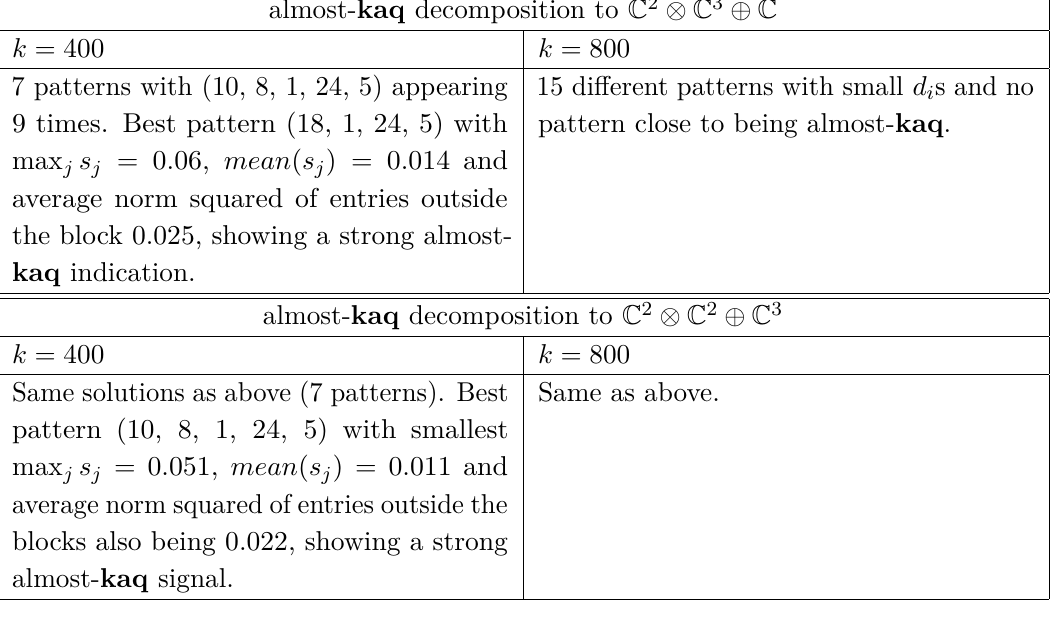
Table 11 . Almost- kaq nes for L 26 on su (7) . Note that there are 24 entries outside the matrix blocks for the C 2 ⊗ C 2 ⊕ C 3 decomposition, and 12 for C 2 ⊗ C 3 ⊕ C .